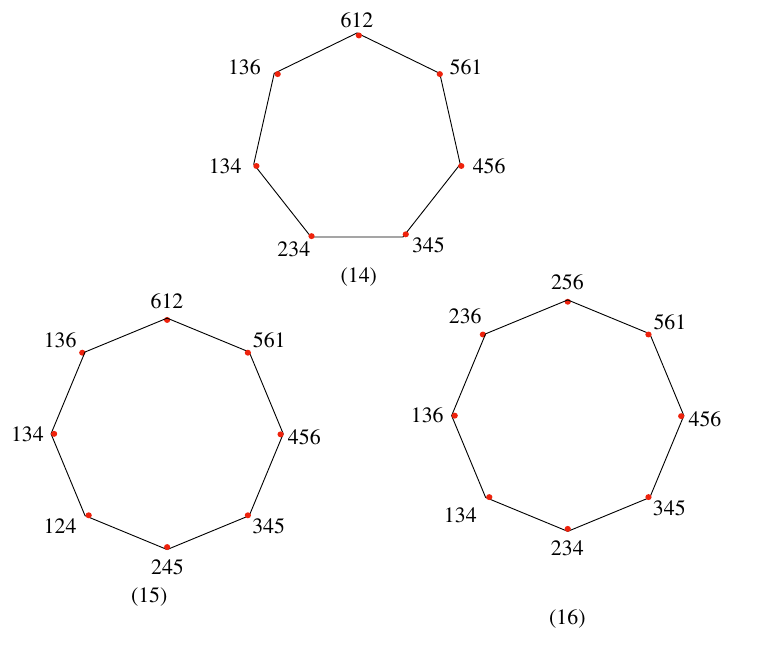
Figure 5 . Polygons for A 345